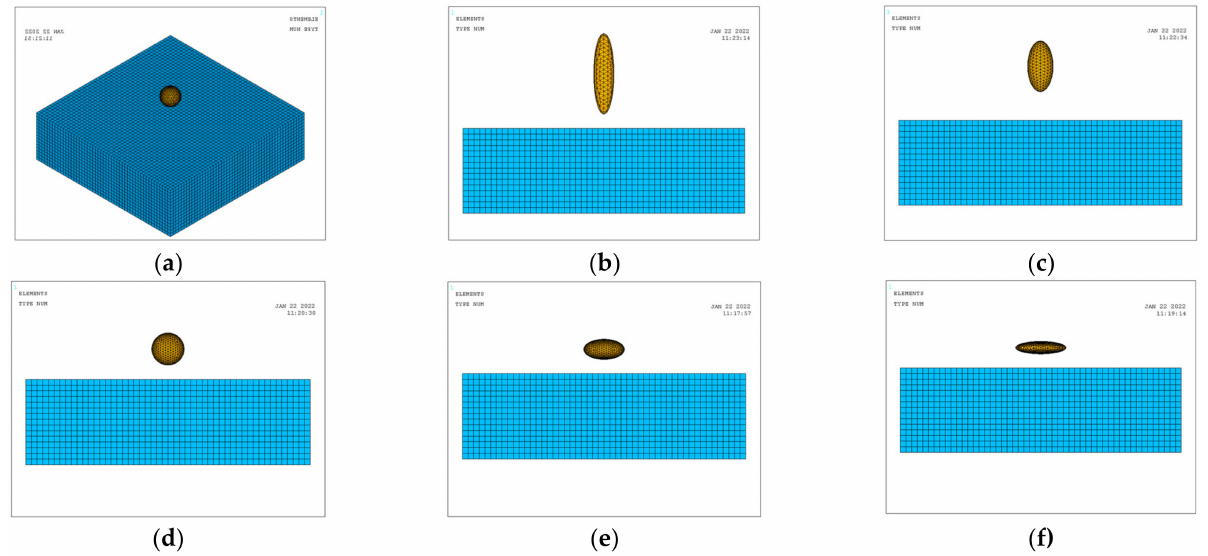
Figure 7. Numerical model. ( a ) The numerical model used in this article as a three-dimensional